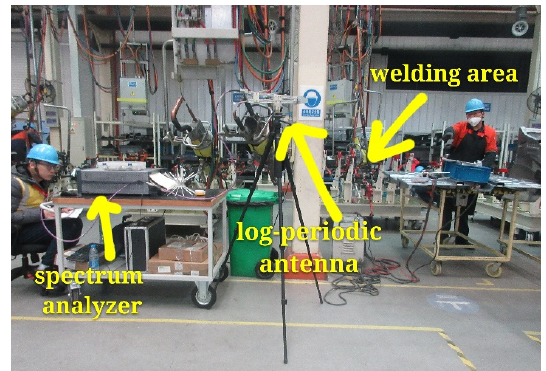
Figure 2. Actual scene of the measurement.